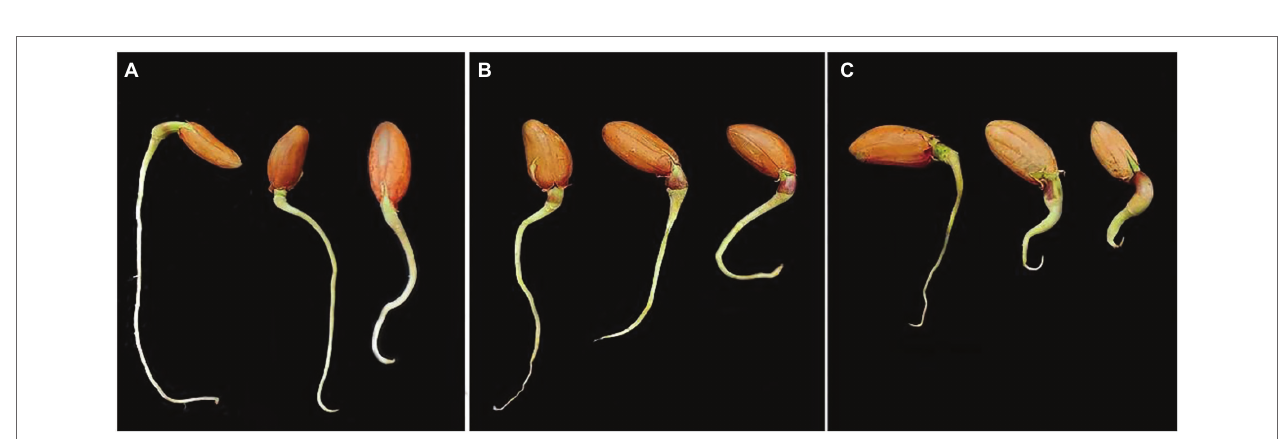
FIGURE 5 | Germination and seedlings characteristics of the tested peanut seeds in accordance with CA treatment.